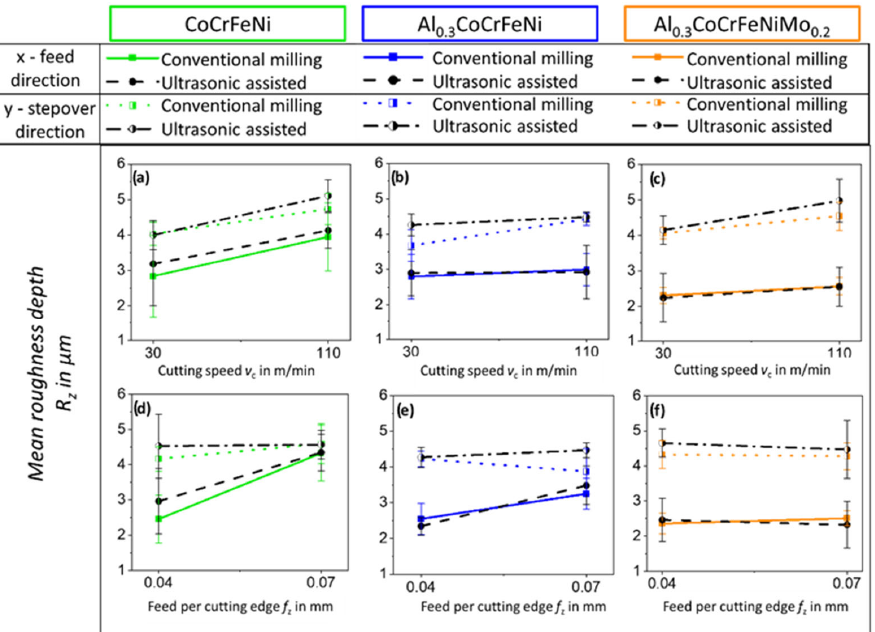
Figure 9. Results of mean roughness depth R z from tactile roughness measurement on feed and stepover directions. Effect diagrams showing the influence of cutting speed ( a – c ) and feed per cutting edge ( d – f ) under conventional milling and USAM. Table 3. Influence of feed per cutting edge on theoretical roughness R zth in feed and stepover directions. Feed per Cutting Edge f